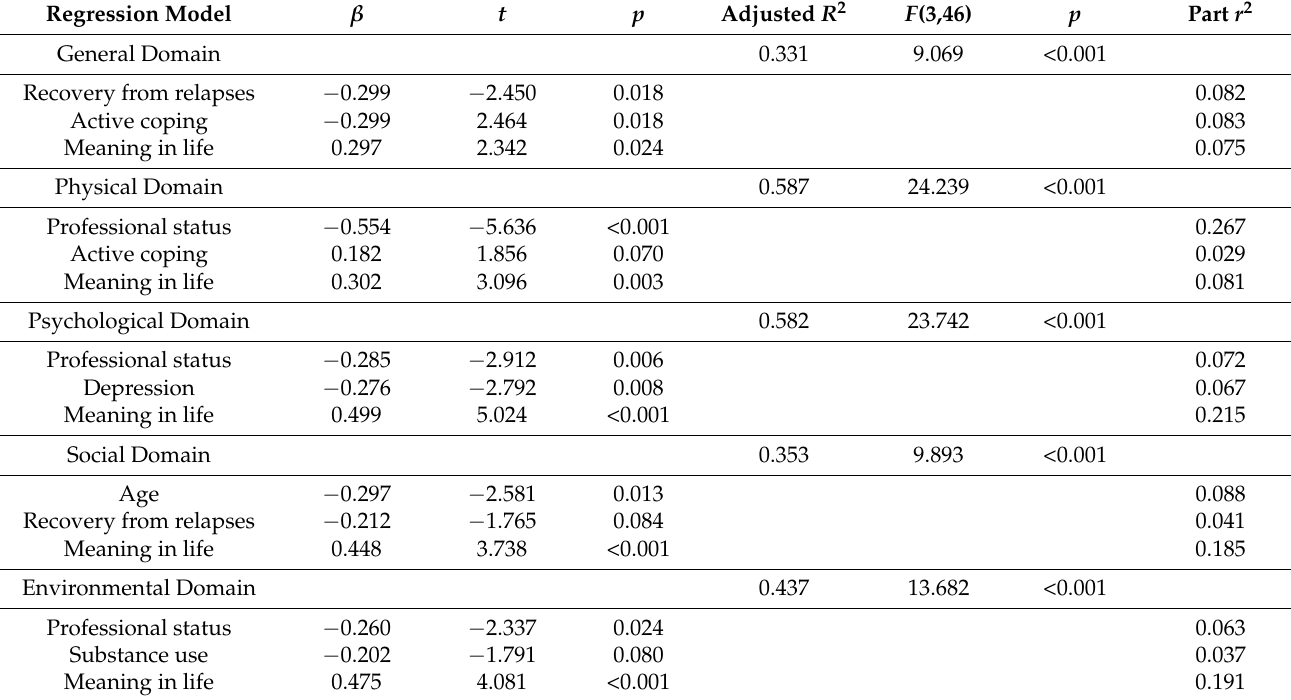
Table 4. Multiple regression models for the QoL